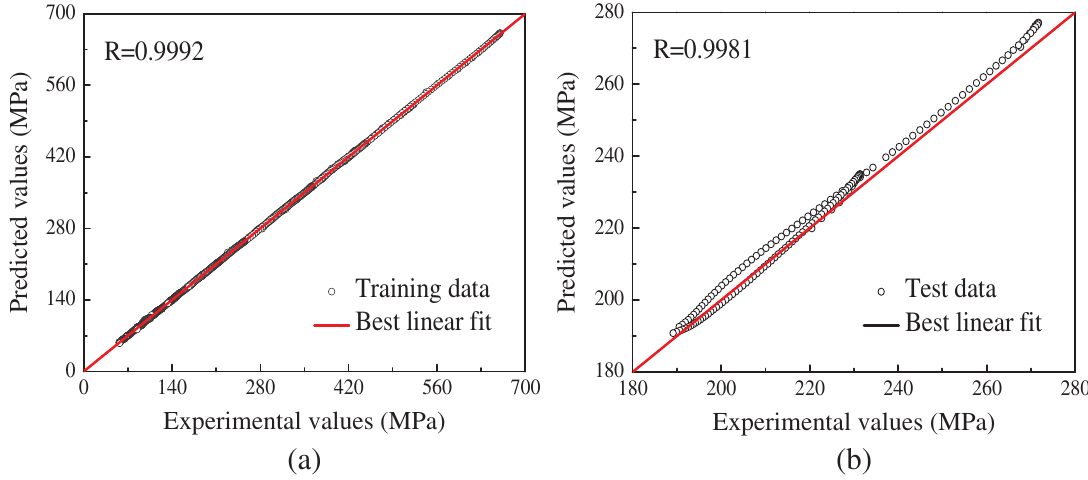
Figure 5: The correlation relationships between the predicted and experimental true stress for the (a) training part and (b) test